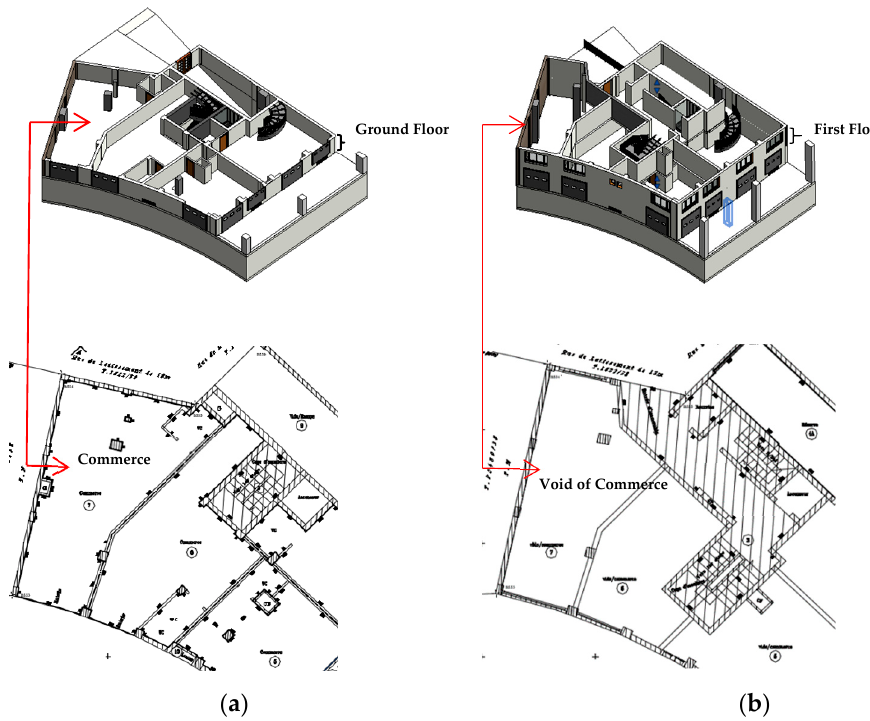
Figure 9. ( a ) The representation of commerce in 2D drawings (ground floor); ( b ) The representation of the void of commerce in 2D drawings (first floor). 3. This situation includes two RRRs: (a) a right-of-way easement represented by the arcade area located on the ground floor and extended to the first-floor level, and (b) a right of usage for a single co-owner, who exclusively benefits from the terrace. The 3D extent of the two rights are represented by Figure 10a,b.